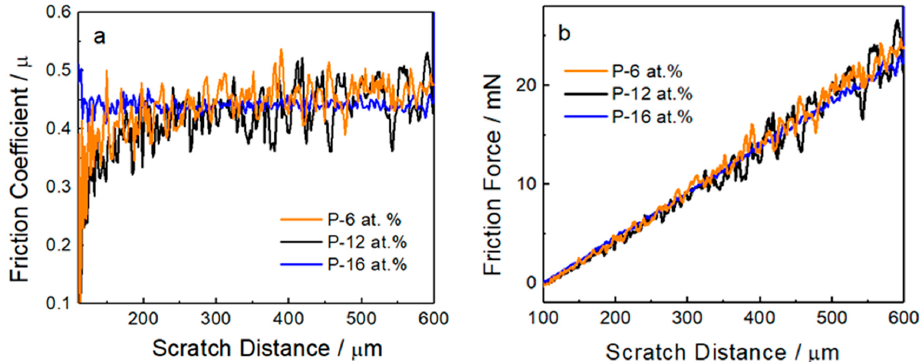
Figure 9. ( a ) Friction coefficient and ( b ) Friction force of measured Fe-P coatings with varying phosphorous content.